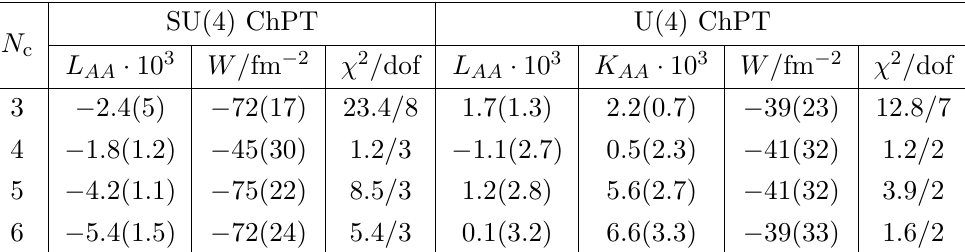
Table 6 . Results of fits ∆ E AA to SU(4) and U(4) ChPT at fixed N c .